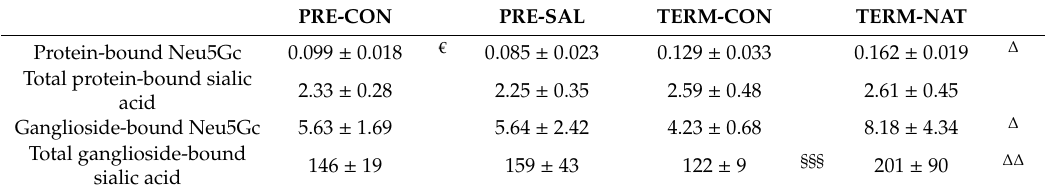
Table 2. Sialic acid levels in hippocampal tissue. Values for protein-bound fractions are presented as µ g / g protein whereas ganglioside-bound fractions are presented as µ g / g wet weight tissue.